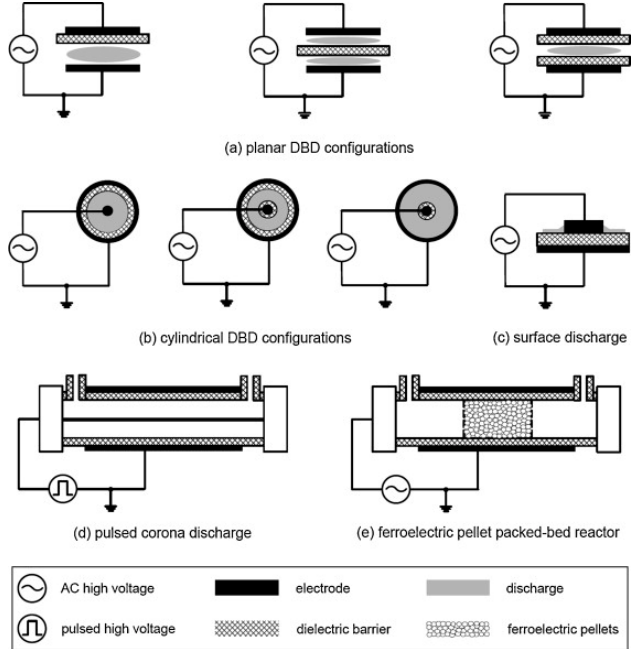
Figure 4. Several configurations of NTP reactors. Reprinted from Reference [52], with permission from Elsevier.